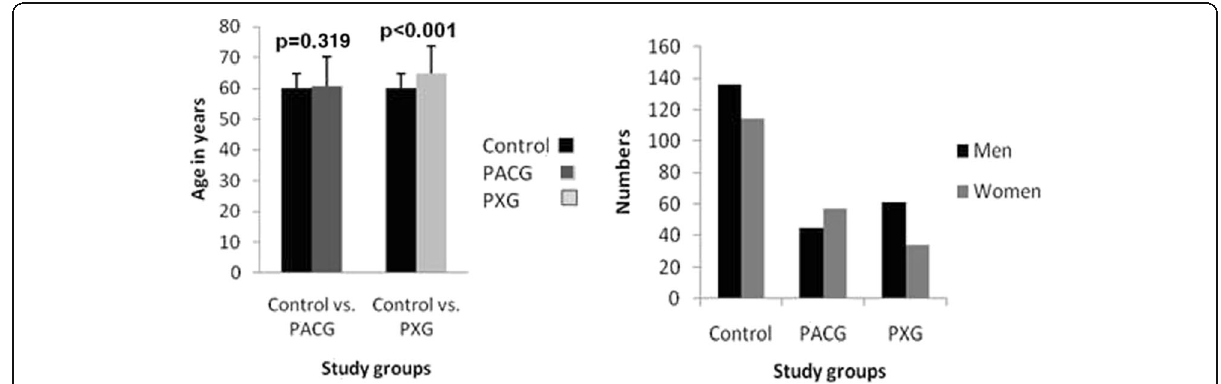
Fig. 1 Demographic data distribution of subjects included in this